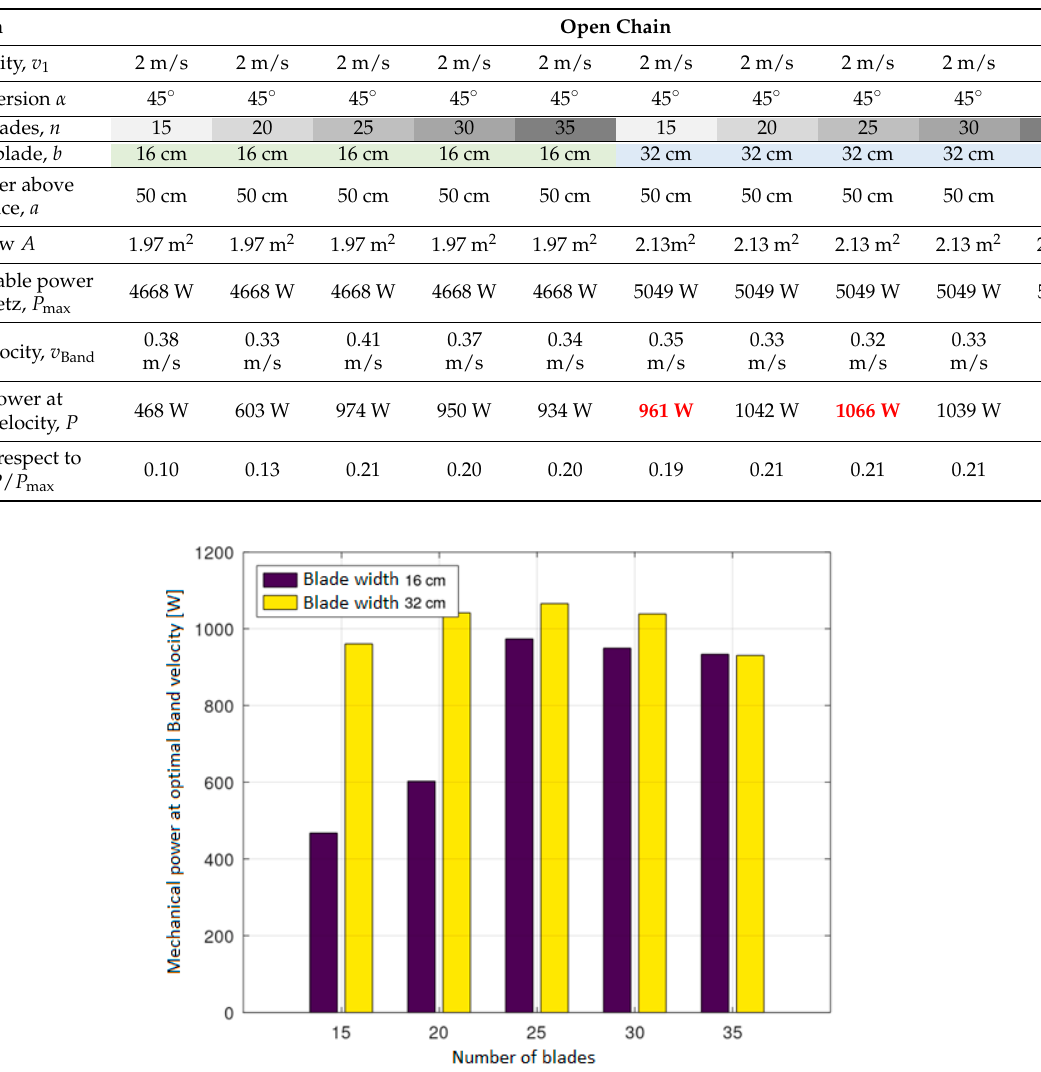
Figure 12. Mechanical power for Result summary III.